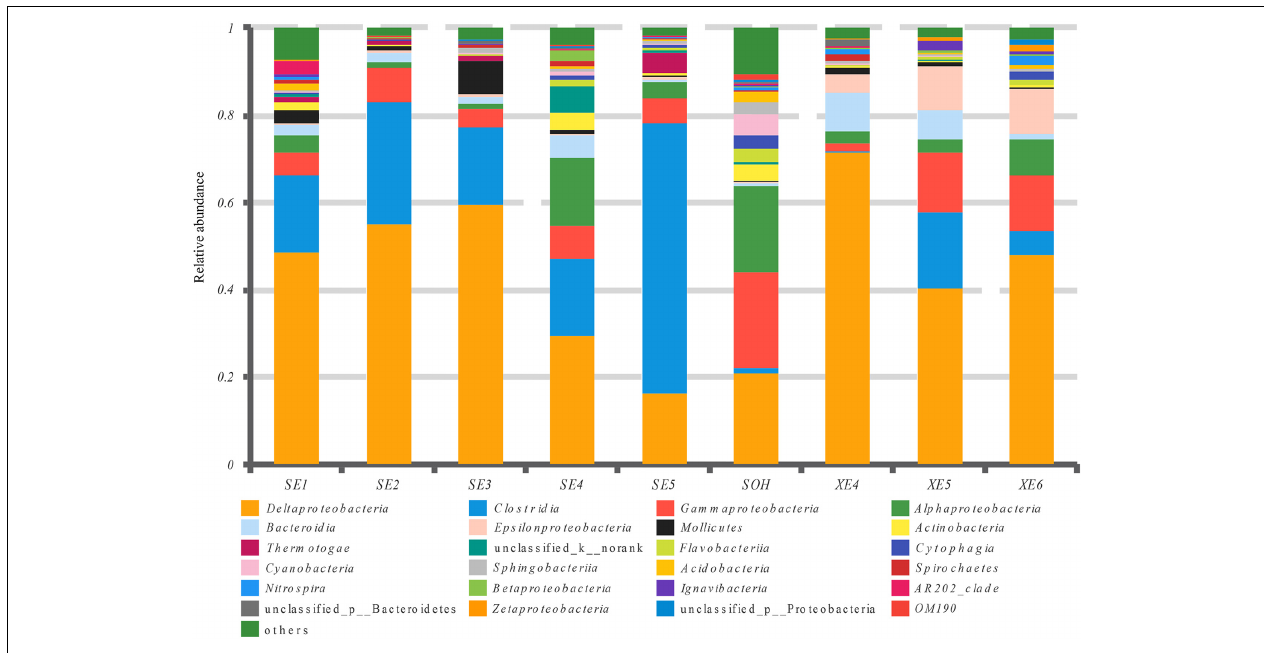
FIGURE 5 | Relative abundances of bacterial 16S rRNA gene sequences from the corrosion samples presented at the class level.